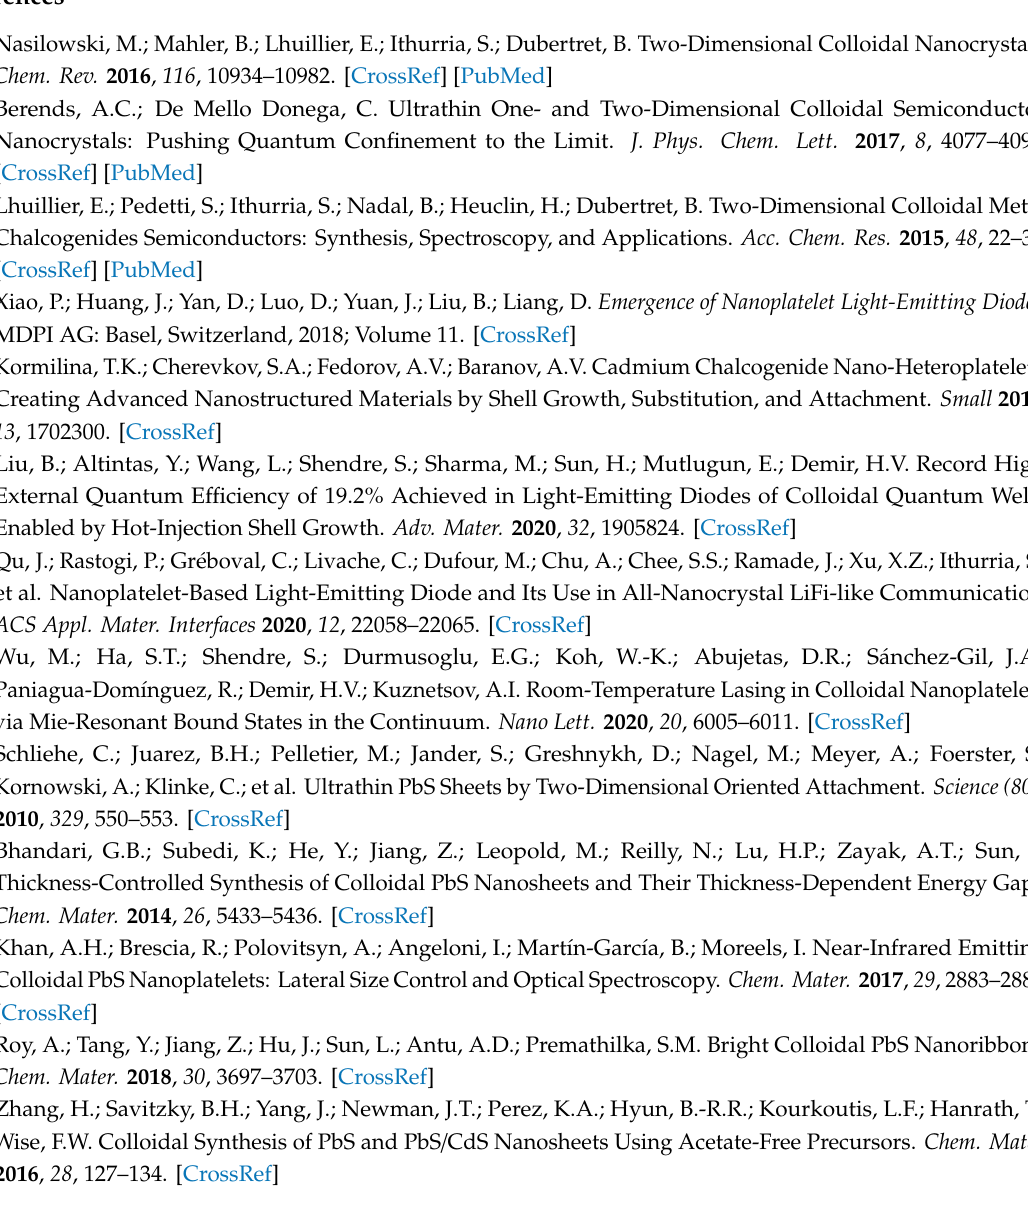
Materials and methods, Figure S1: TEM images of NPLs and QDs, Figure S2: Fit residuals for NPLs PL decay and PL spectra, Figure S3: Raman spectra for PbSe QDs and NPLs, Figure S4: CdSe NPLs PL data, Figure S5: PbSe QDs PL data, Table S1: Assessment of transitions in Raman spectra, Table S2: PL parameters for PbSe